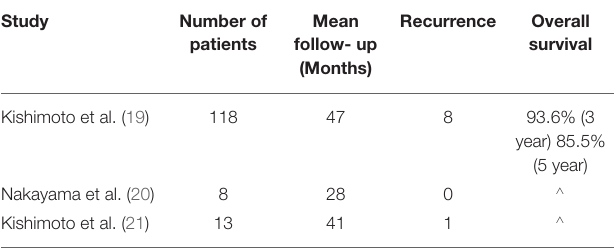
TABLE 2 | Summary of the studies involved in the systematic analysis of ELPS.